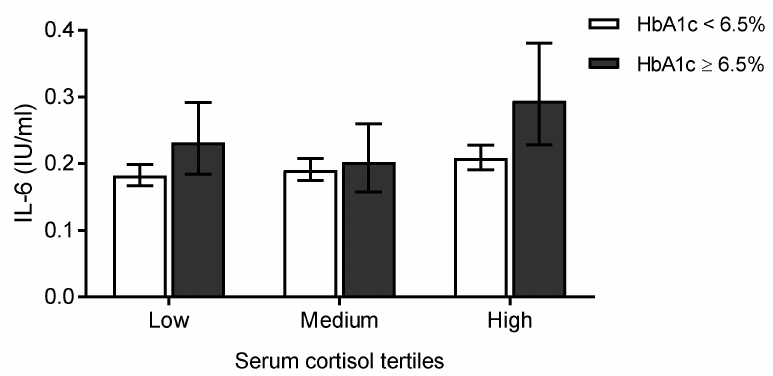
Figure A1. Association of serum cortisol, Interleukin-6 (IL-6) and HbA1c.